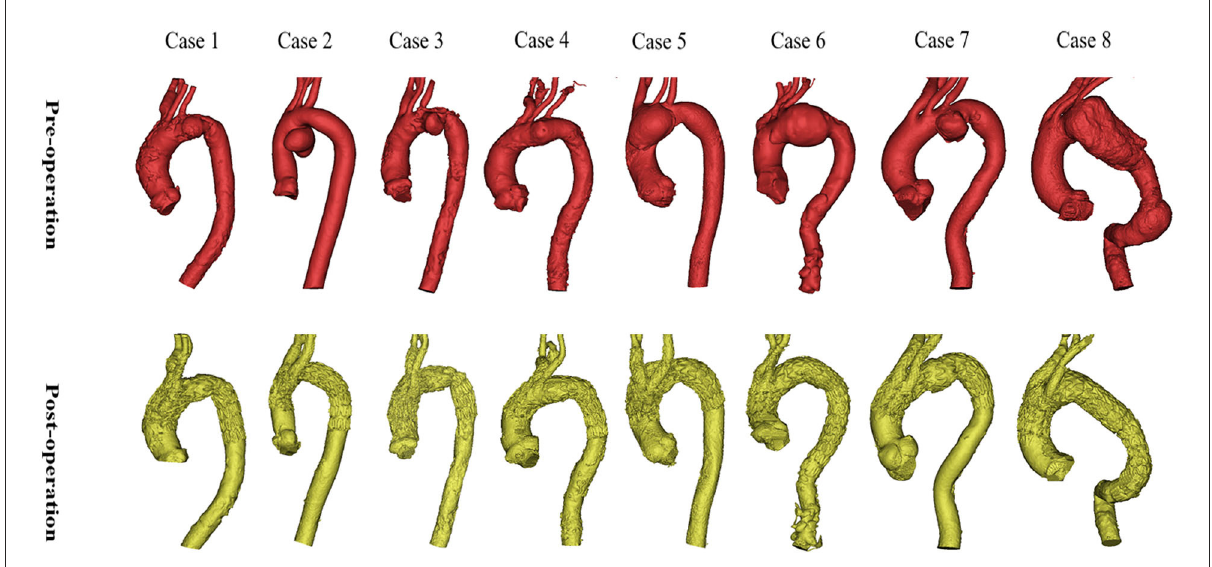
FIGURE4 Preoperative and postoperative morphologies of the eight interventions. The morphologies and locations of the eight lesions are shown in the above images. The reconstructions of the arch and branch vessels are shown in the below images.